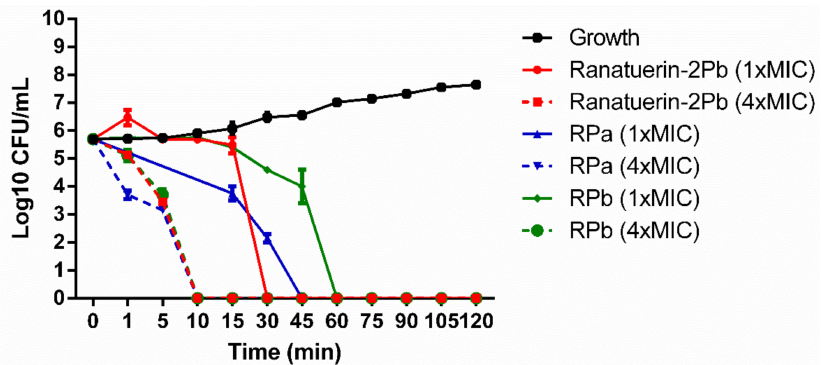
Figure 5. Time-killing curve of S. aureus by ranatuerin-2Pb, RPa and RPb at di ff erent concentrations. Growth control correspond to bacteria incubated in PBS without peptide. Data represent means ± SEM of three independent experiments.